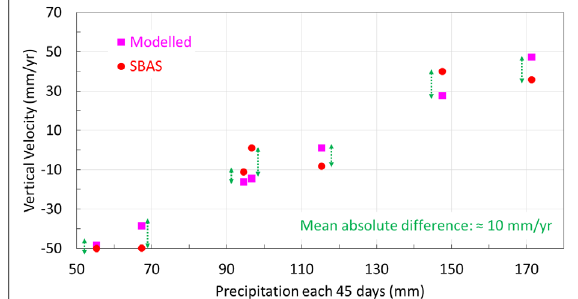
Figure 7. Vertical velocity (mm/yr) of target points (TP) 1 – 6 (Figure 3) in 2017. Velocity precision ≈ 2 mm/yr. Positive and negative, up and down movements, respectively.